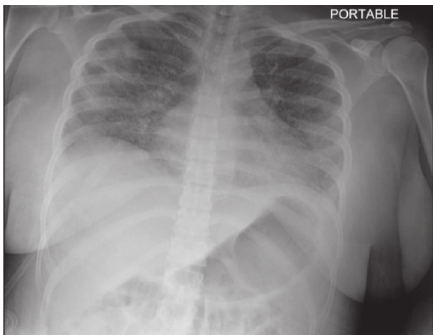
Figure 1: Portable chest X-ray film from our patient on day 5 of admission showing bilateral multifocal airspace opacities consis- tent with